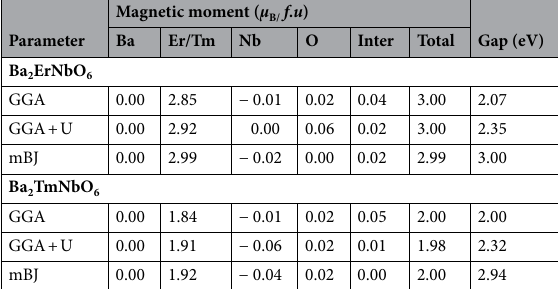
Table 3. Spin magnetic moment of Ba 2 Er/TmNbO 6 perovskites.